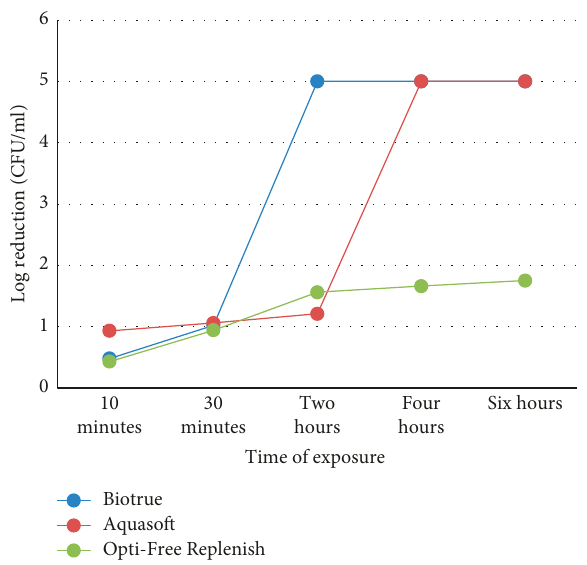
Figure 1: Effects of different MPS and length of exposure on the concentration of Staphylococcus aureus .